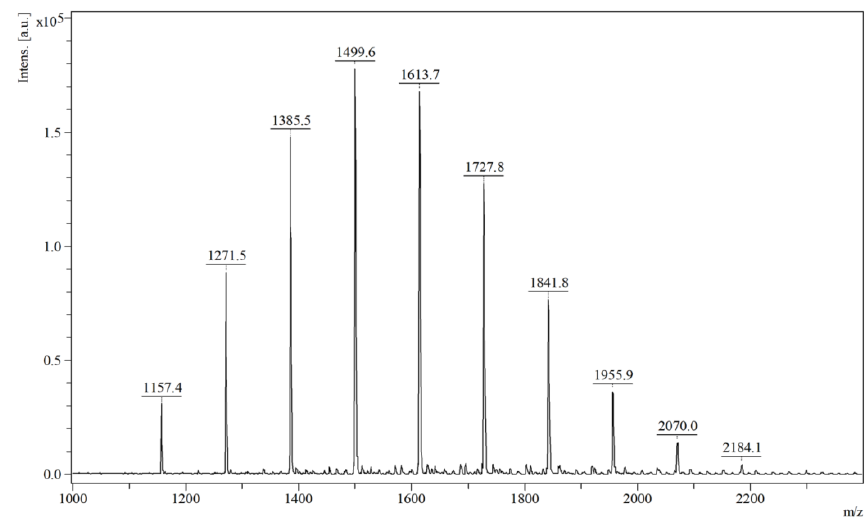
Figure 1. MALDI MS spectrum of a typical CDCL product (obtained from #2).